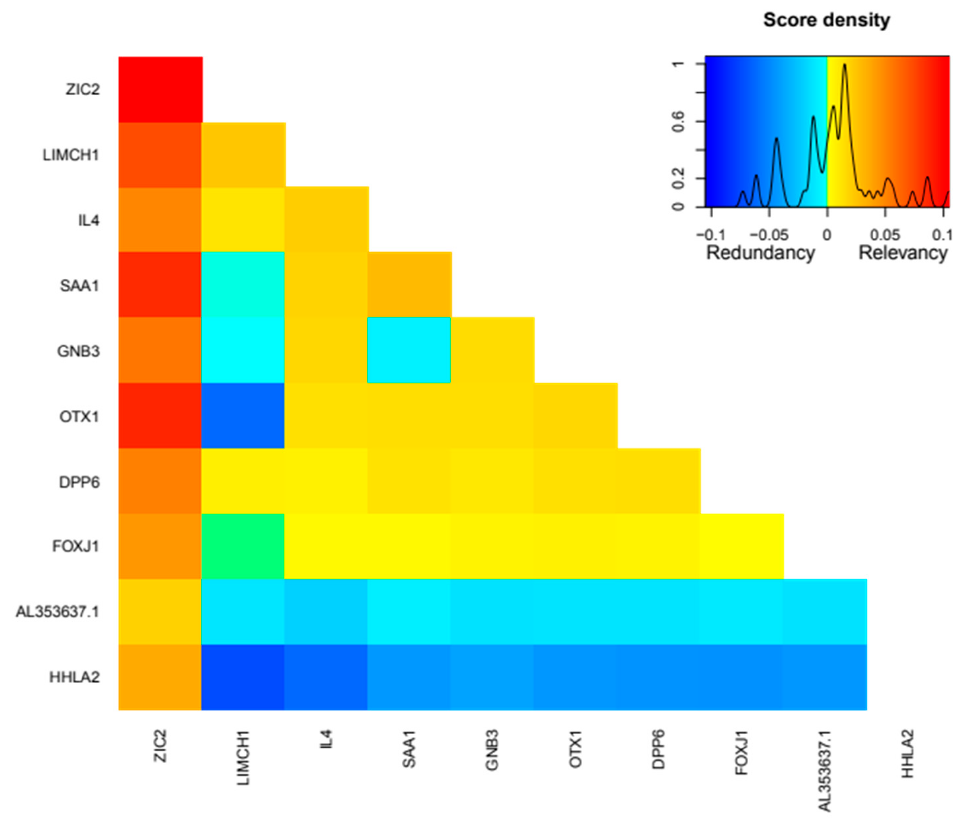
Figure A3. Variable ranking based on mutual information of 10 most important genes of mRMR 13-gene signature of ccRCC. The most representative genes with respect to AJCC Staging of TCGA dataset.